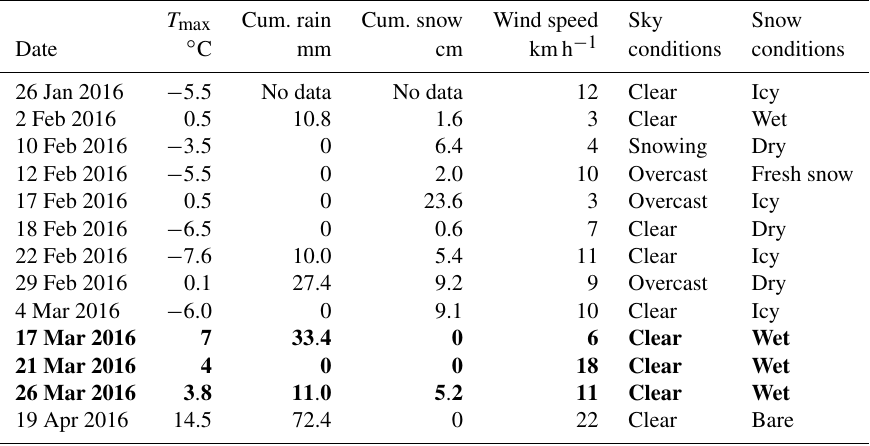
Table 2. Environmental conditions during P3P missions over Gatineau. Rain and snow correspond to cumulated totals since the previous mission. Melt periods are in bold font.